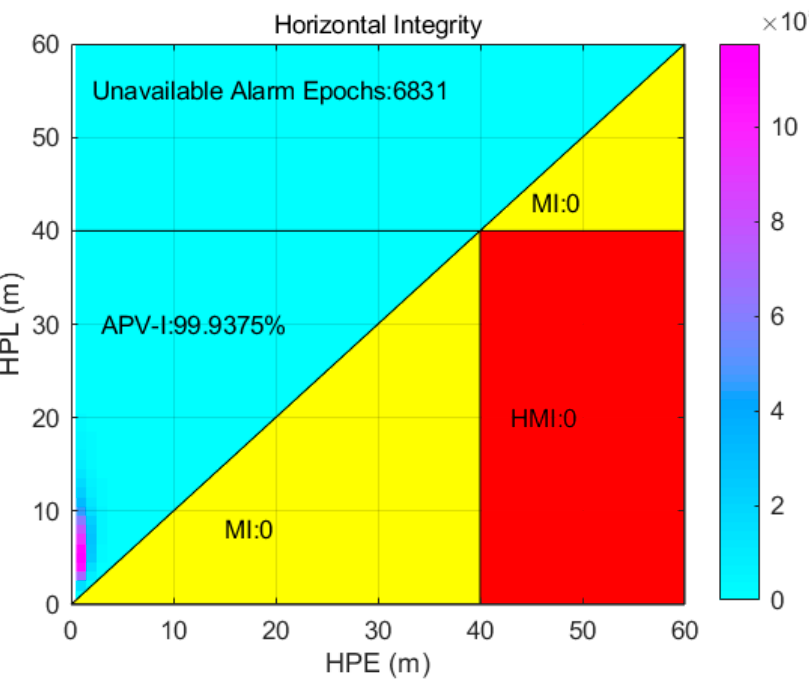
Figure 7. Horizontal integrity assessment with Stanford diagram. No misleading information (MI) and no hazardously misleading information events exist. The 99.9375% testing epochs are operating within their normal bounds in horizontal direction according to APV-I approach requirement.